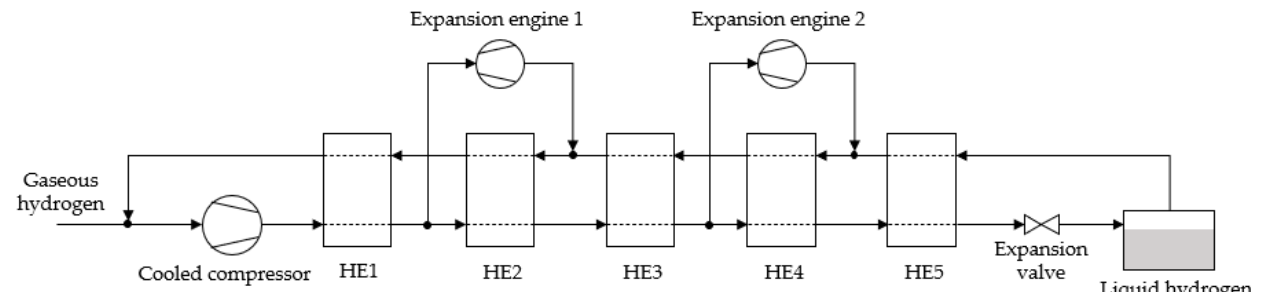
Figure 7. Basic schematic diagram of Collins process for hydrogen liquefaction.